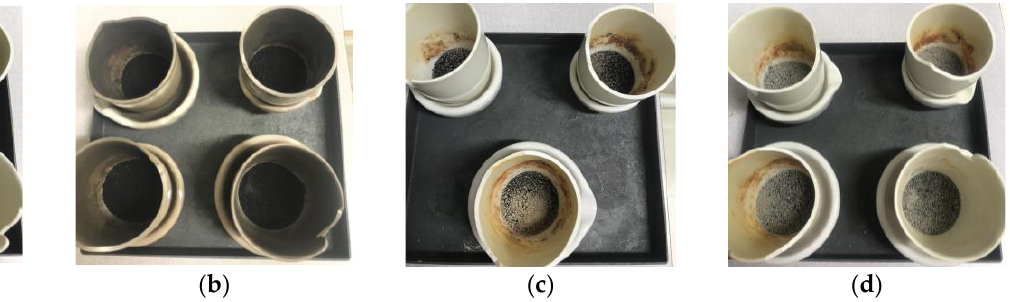
Figure 5 . ( a ) Borås sludge sample before pyrolysis, ( b ) Char after pyrolysis at 500 °C, ( c ) 700 °C, and ( d ) 900 °C.